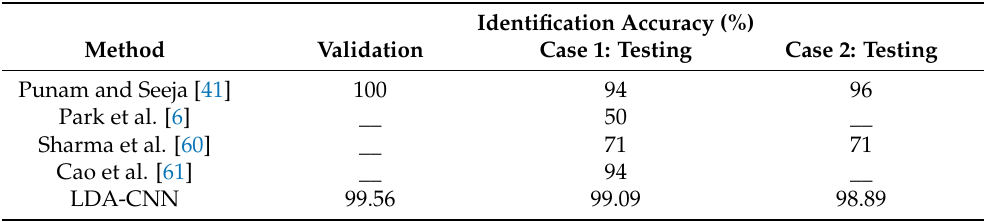
Punam and Seeja